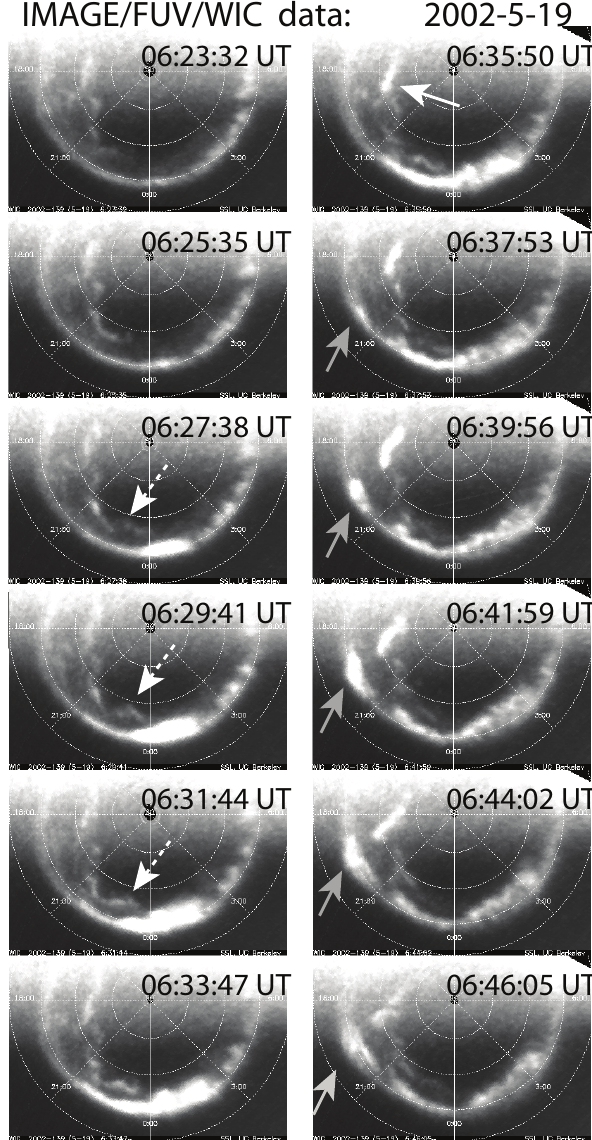
Fig. 4. IMAGE/FUV Wideband Imaging Camera (WIC) data in the magnetic coordinate (GMLat and MLT) during 06:23 ∼ 06:46UT on 19 May 2002 taken from the Northern Hemisphere (bottom is 00MLT and left is 18MLT, covering 50 ◦ ∼ 90 ◦